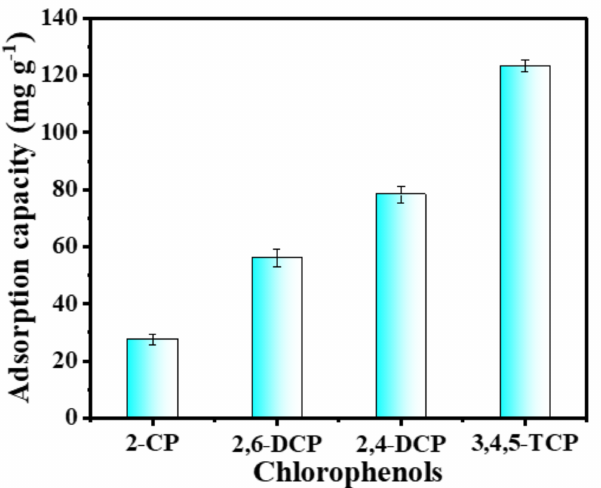
Figure 10. Adsorption capacity of the C–O/W microcapsules towards different PEDs.